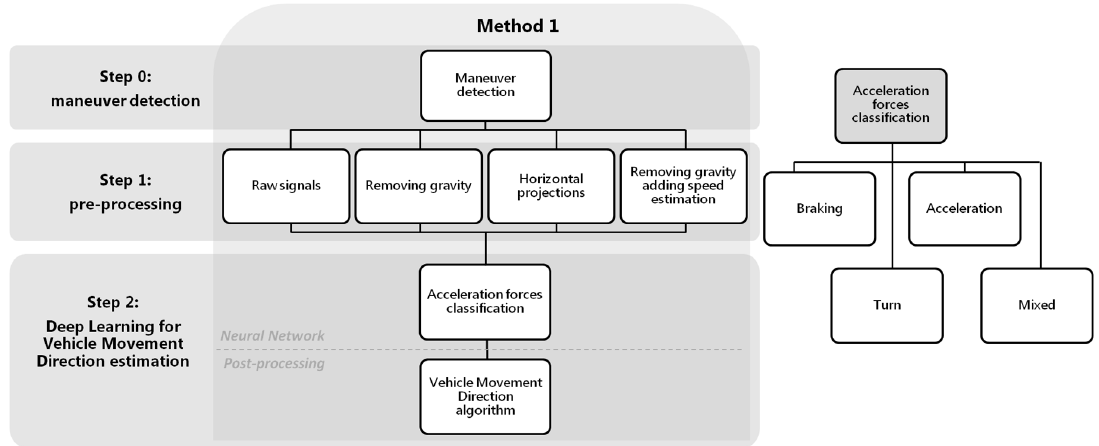
Figure 5. Scheme method 1, maneuvers classification.